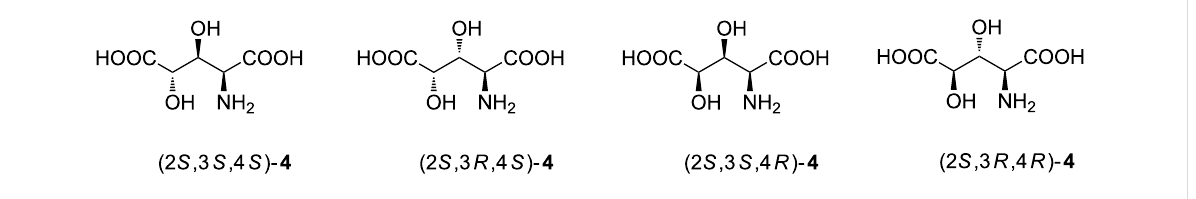
Figure 5: Enantiomers of 3,4-dihydroxy-L-glutamic acid ( 4 ).